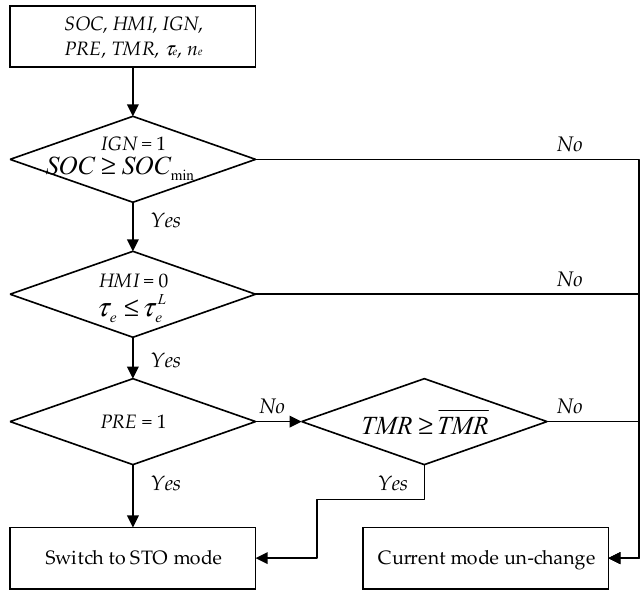
Figure 10. Logics for STO mode decision.